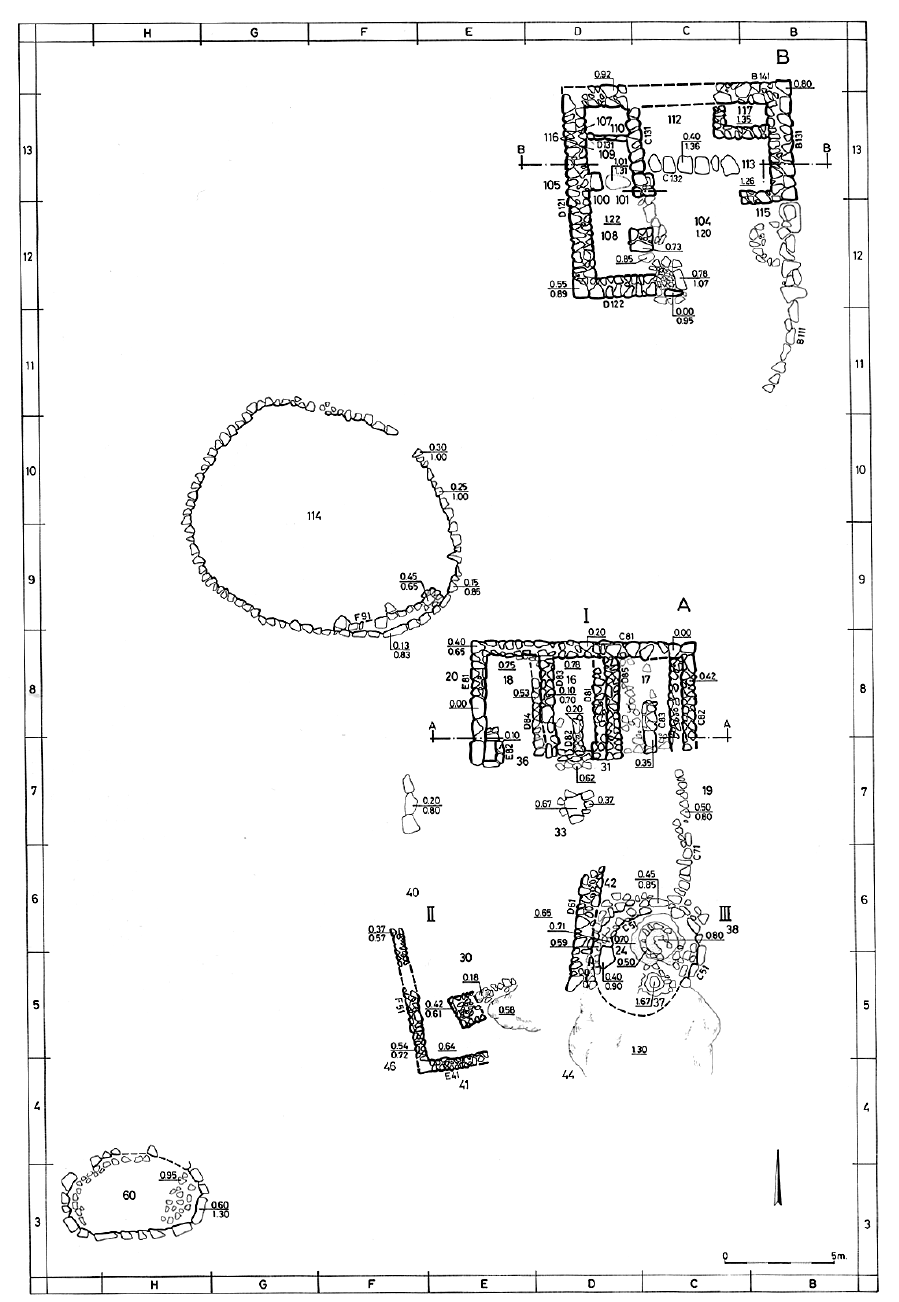
Figure 13 Plan of the Horvat Qitmit shrine. After Beit-Arieh 1995, Fig. 1.6. With kind permission from the Institute of Archaeology, Tel Aviv